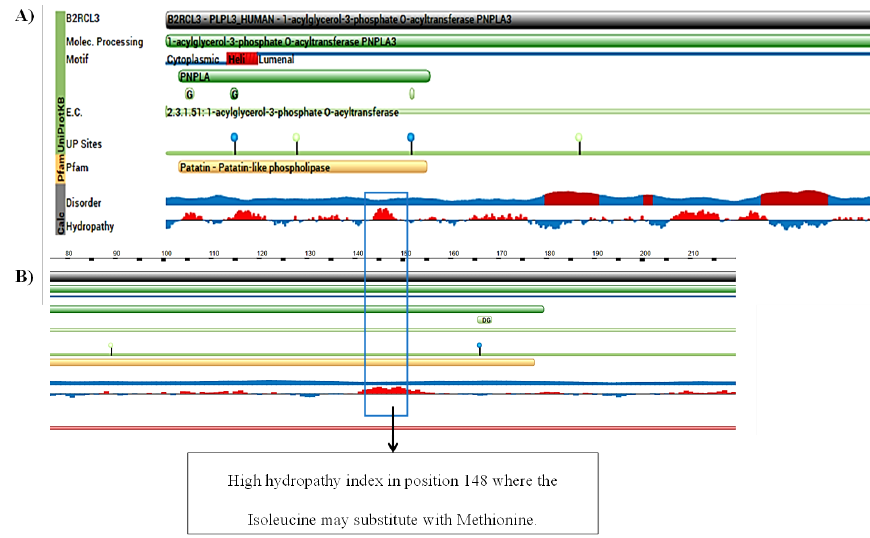
Figure 6. A and B Results Obtained by the PDB Database. Note . Different rows indicate different indicators of the conserved patatin domain in the PNPLA3 protein. The parts showing a higher hydropathy index resulted in higher peaks appearing in the red color.